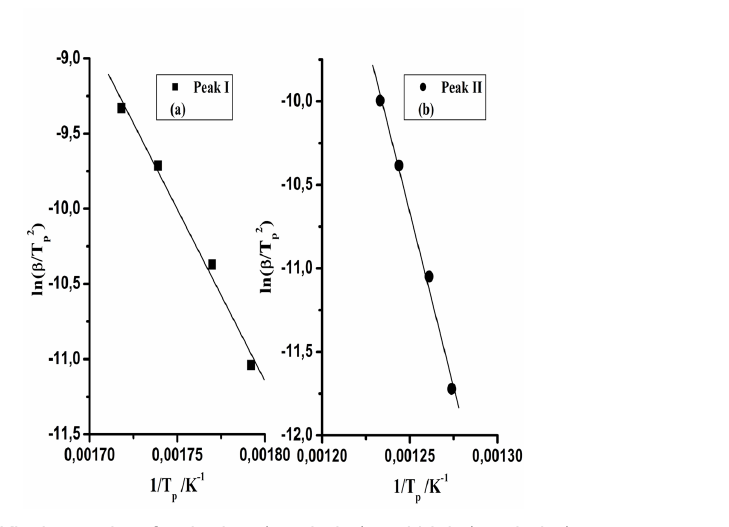
Figure 4 – The Kissinger plots for the low (symbol ■ ) and high (symbol ● ) temperature peak (I (a) and II (b)) at different heating rates, for the considered crystallization process of the amorphous Fe 81 B 13 Si 4 C 2 alloy Slika 4 – Kisindžerove prave za nisko temperaturni (simbol ■ ) i visoko temperaturni (simbol ● ) pik I (a) i II (b)) na razli č itim brzinama zagrevanja, za razmatrani proces kristalizacije amorfne Fe 81 B 13 Si 4 C 2